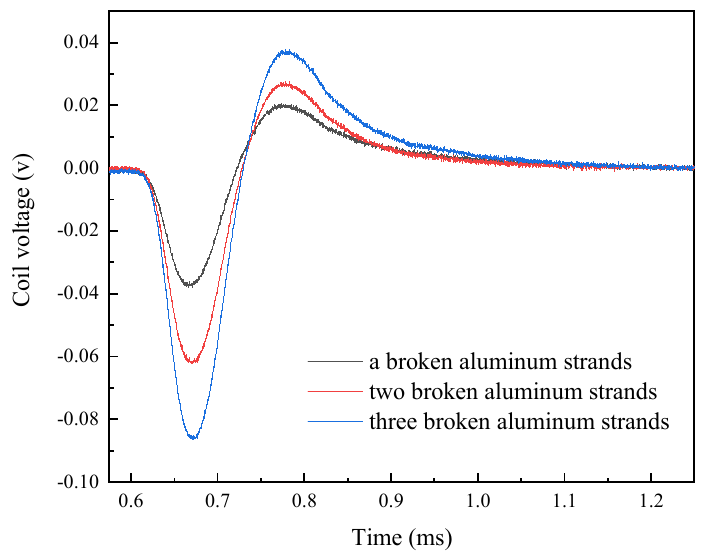
Figure 9. Output signals of the coil voltage with different broken aluminum strands. Figure 10 shows the variations in the peak value and the peak arrival time with an increase in the number of broken strands. It can be observed that the peak height and peak arrival time increased with the number of broken Al strands, suggesting that the number of broken Al strands can be determined by observing the peak value and the peak arrival time.